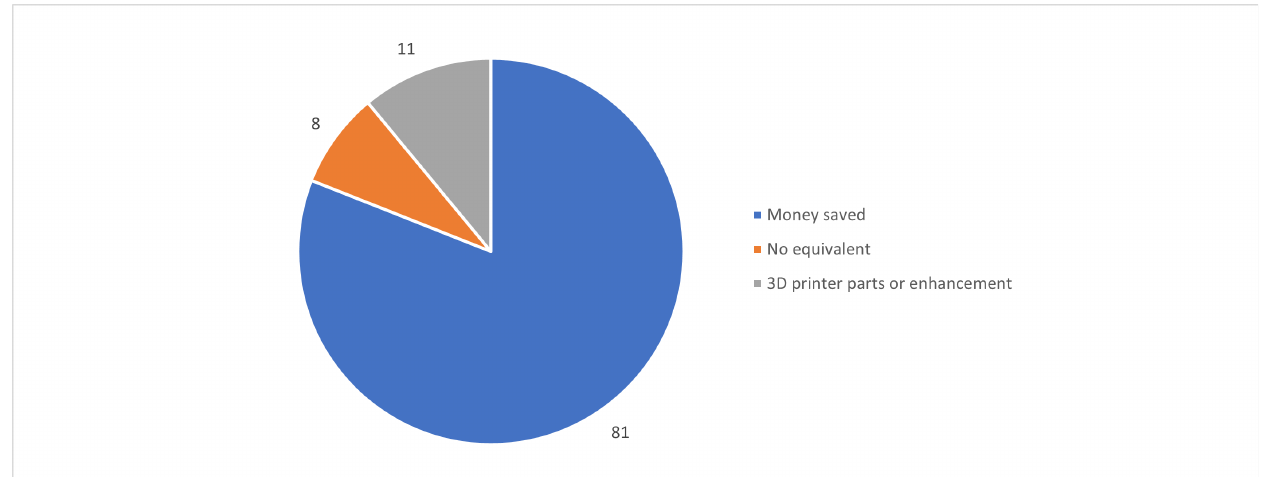
Figure (1): Main category for the 100